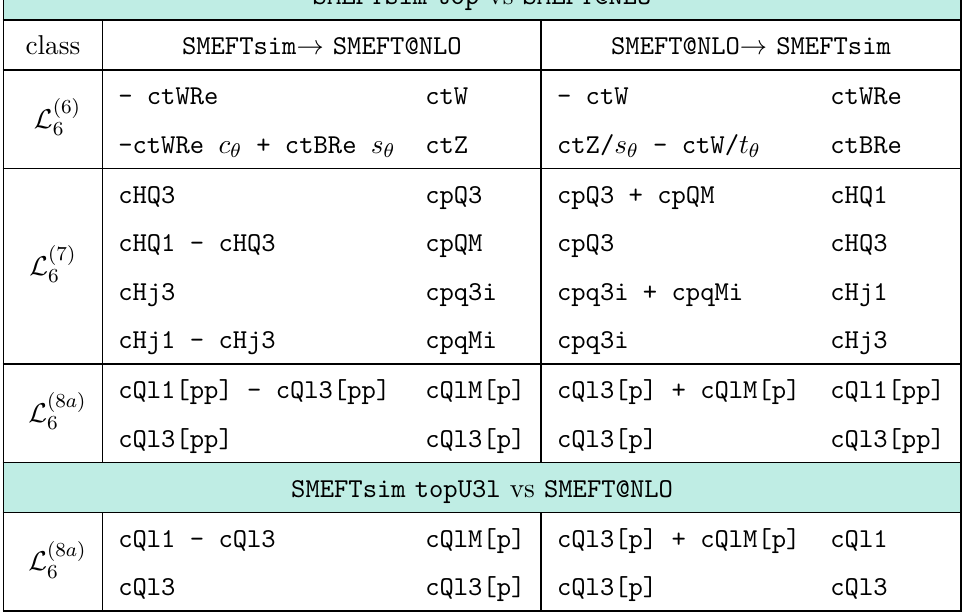
Table 29 . Upper panel: conversion table between the SMEFT parameters defined in the top version of SMEFTsim and in SMEFT@NLO v1.0 : parameters that require a basis rotation. Lower panel: conversion table between the topU3l version of SMEFTsim and SMEFT@NLO . Only leptonic coefficients are reported here, as the other parameters behave identically to the top case. Lepton flavor indices take values p = { 1,2,3 }